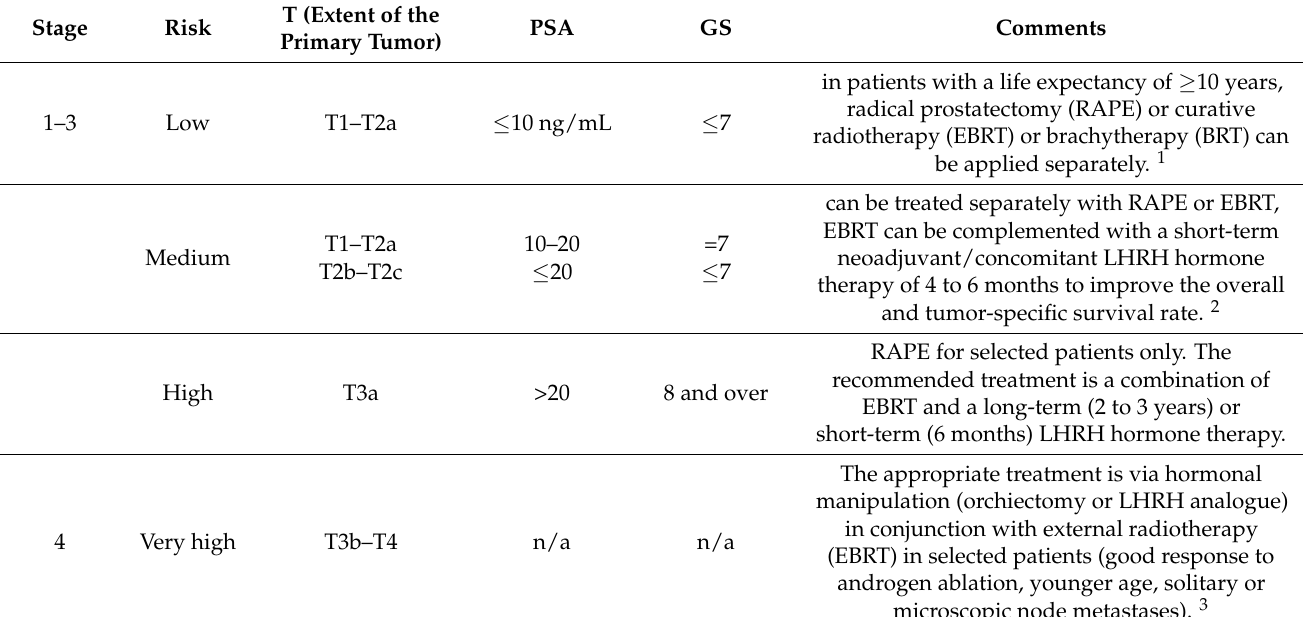
Table 1. In asymptomatic patients with a life expectancy of < 5 years + low (PSA) + low GS (Gleason score), the watchful waiting method is selected [14,15]. prostate-specific